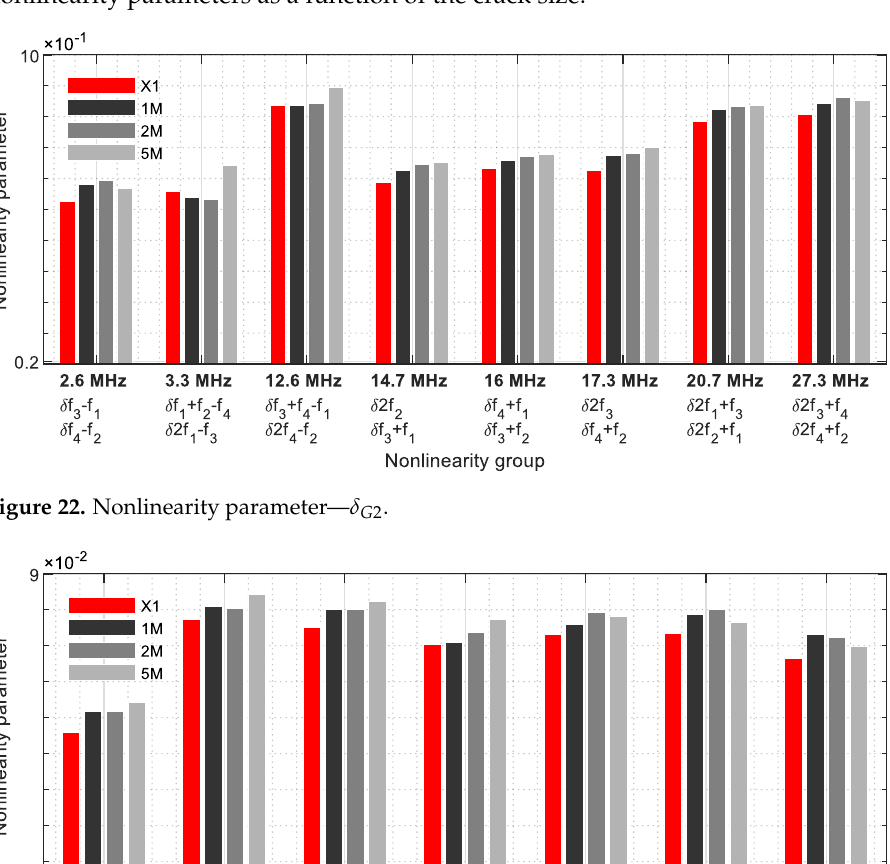
Figure 23. Nonlinearity parameter — δ G3 .